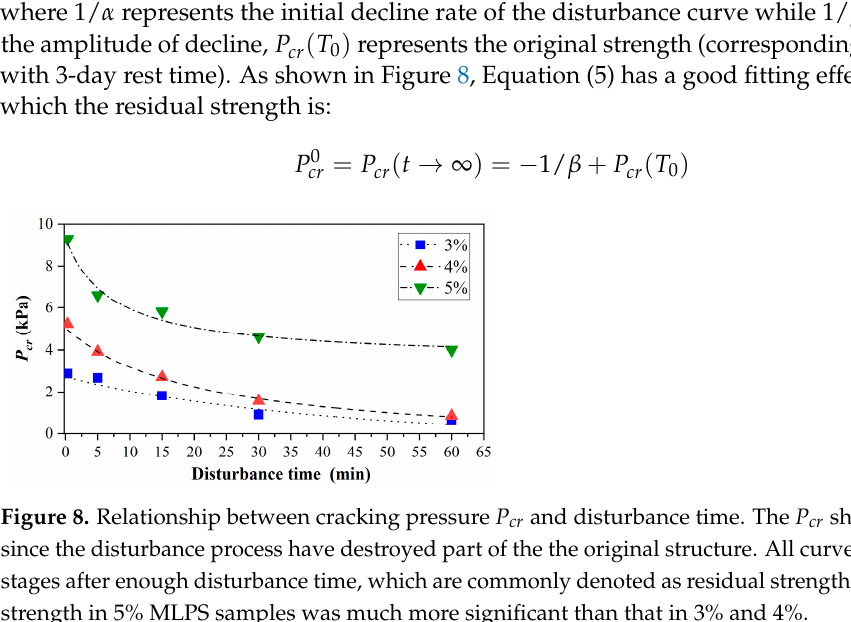
Figure 9. Relationship between 1/ α , 1/ β , and concentration. 3.4. Influence of Recovery Time Figure 10 shows that cracking pressure varies with recovery time, where the MLPS transparent soils had rested for 3 days and were disturbed at 2000 rpm for 60 min. Addi- tional recovery time was considered to testify to thixotropy. As shown in Figure 10, the cracking pressure recovered instantaneously after the completion of disturbance, whose response was homology to the elastic recovery and denoted as